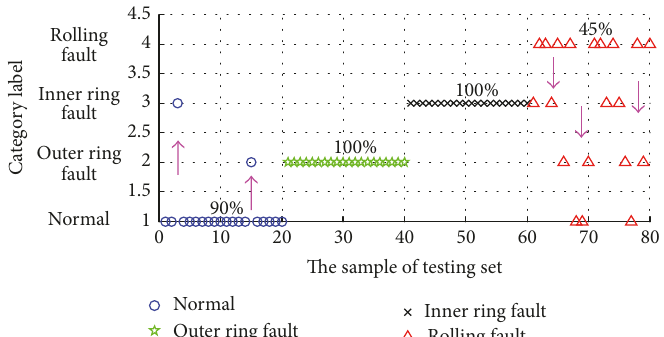
Figure 14: Classification of testing data based on SVM.